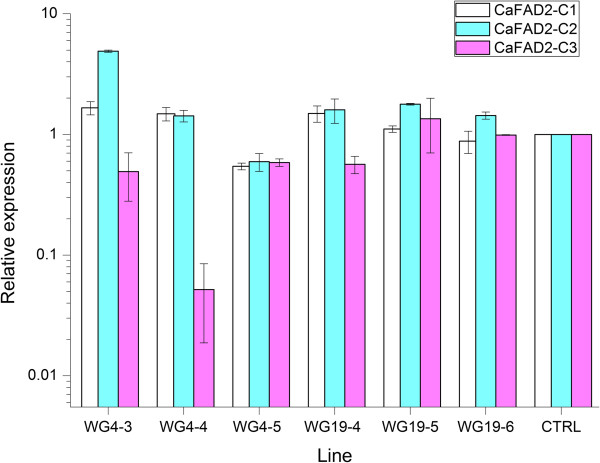
Relative expression levels of CaFAD2 gene family members in the seeds of T1 plants of C. abyssinica. Six T1 plants (WG4-3, WG4-4, WG4-5, WG19-4, WG19-5 and WG19-6) and a control (CTRL) were measured. Qantitification was performed by qPCR for bulk seeds (five to ten, 20 DAP) of each plant. The relative expression levels in the seeds of T1 plants were calculated with 2^-∆∆Ct method using β-ACT2 as a reference gene.